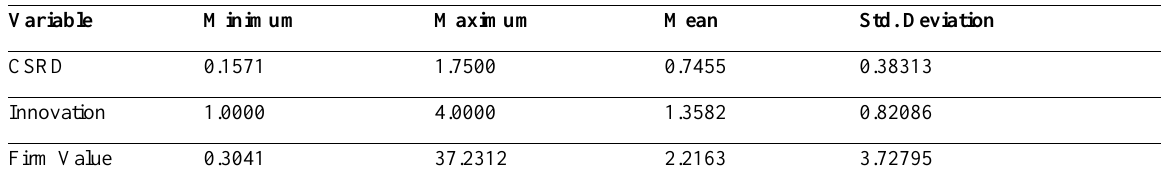
Table 2: Descriptive Statistics